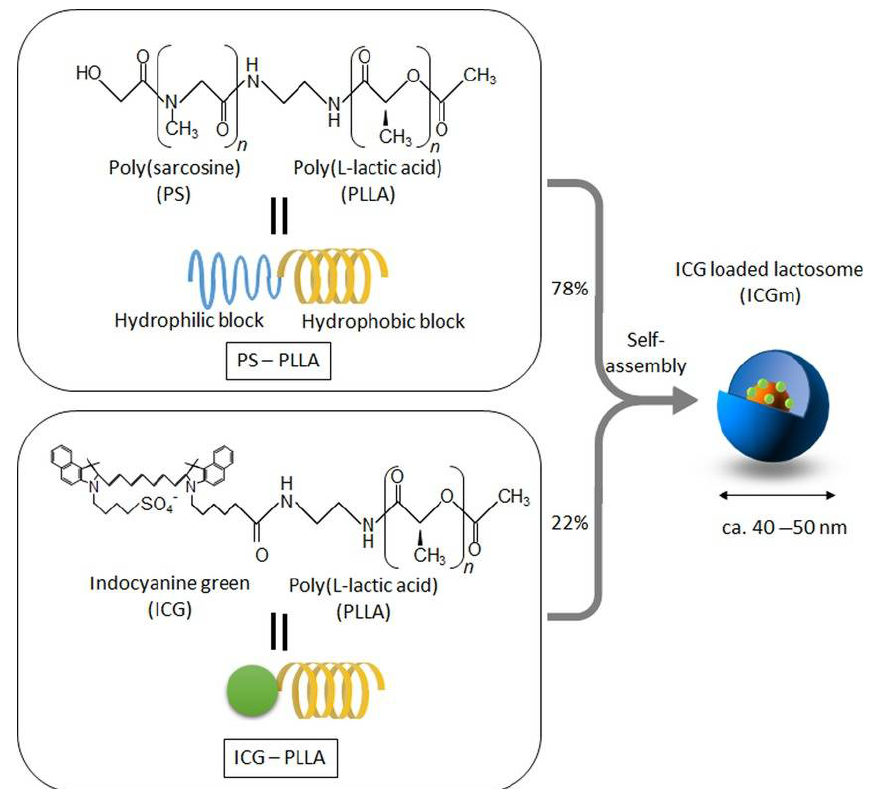
Figure 1. The structure of indocyanine green (ICG)-loaded lactosomes (ICGm’s). ICGm’s are formed by molecular assembly with hydrophobic helical poly-L-lactic acid (PLLA) and hydrophilic polysarcosine (PS) amphiphilic block polydepsipeptide, which include ICG-labeled PLLA in the hydrophobic inner core. (Reprinted from Tsujimoto et al. [9]).